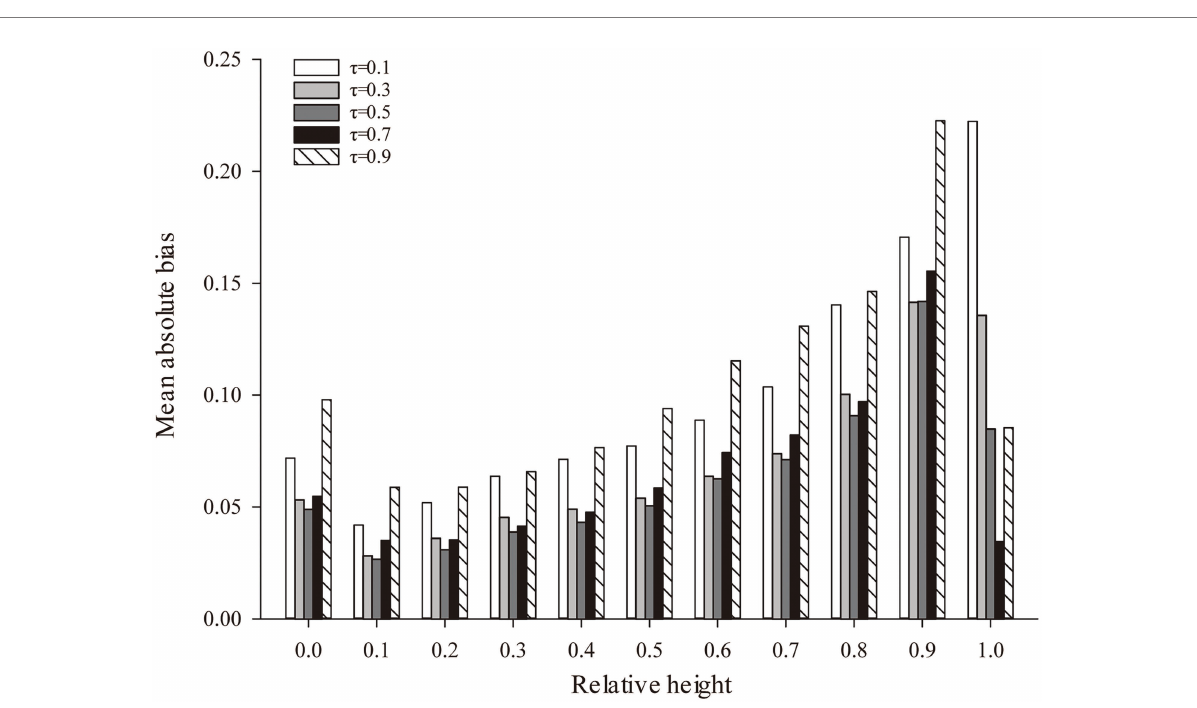
FIGURE 3 The fitting results of different positions of the stem based on the different quantiles. τ , nonlinear quantile regression (NQR) across nine different